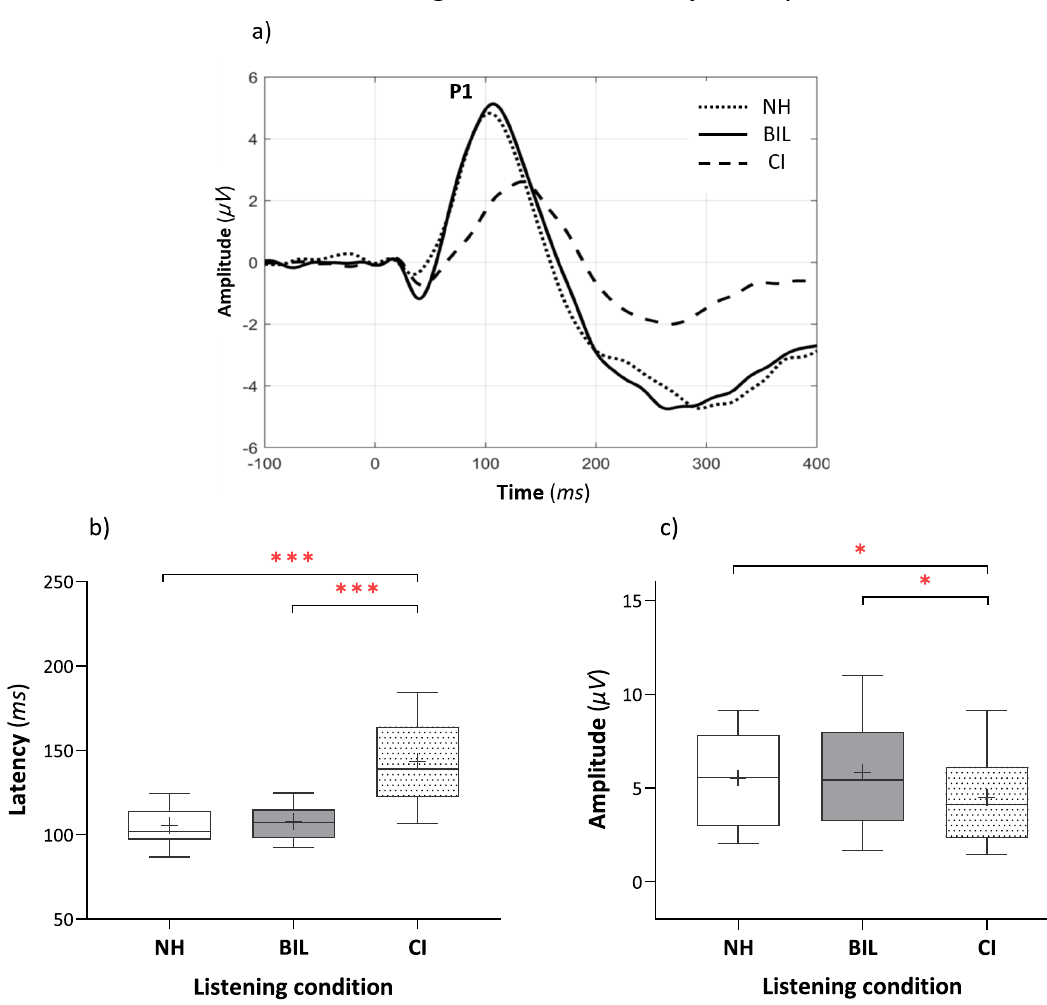
Figure 2. The main effect of listening condition [NH, BIL (NH + CI), CI (NH masked)] on P1 latency and amplitude. ( a ) Grand average CAEP waveforms elicited in the three listening conditions, depicting the significant main effect of listening condition on P1 latency ( p < 0.001) and amplitude ( p = 0.007); ( b , c ) Boxplots illustrating pairwise comparisons. The bottom and top of the box represent the 25th to 75th percentiles (respectively), the middle solid line represents the median, the + symbol represents the mean, and the whiskers extend between the 10th and 90th percentiles. P1 latency was longer and amplitude was reduced in the CI vs. the NH condition ( p < 0.001, p = 0.026, respectively) and to the BIL condition ( p < 0.001, p = 0.021, respectively). Differences between the latencies and amplitudes in the NH and BIL conditions were not significant ( p = 0.853, p = 1.00, respectively). * p < 0.05, *** p <